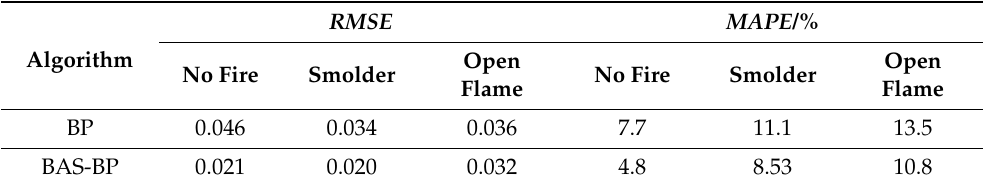
Table 2. Comparison of fire probability error between two algorithms.